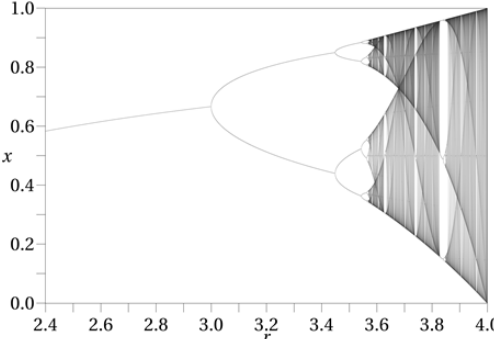
Figure 2. Bifurcation diagram for the logistic map as a function of r.